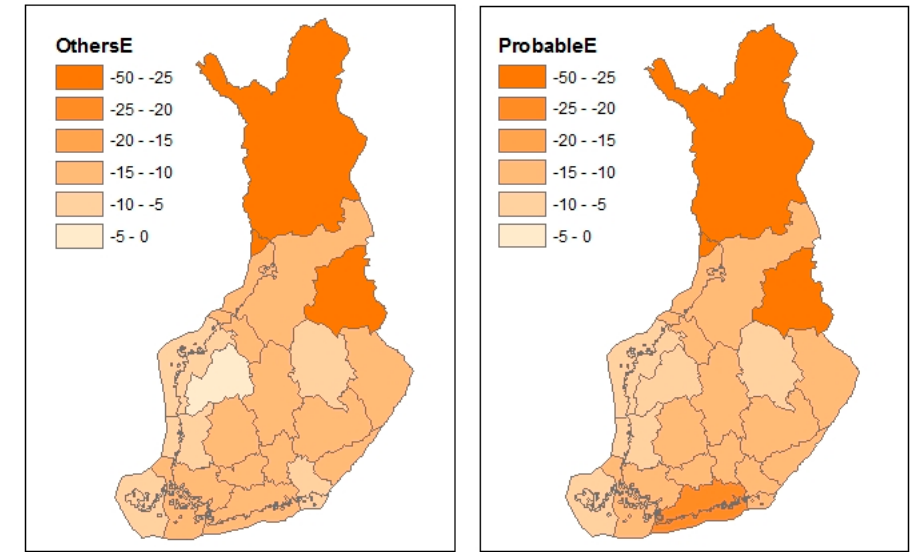
Figure 3. Estimated roundwood removals in 2016–2025 according to the scenarios OthersE and ProbableE, compared to the wood removal in the estimation without restrictions (WRE) scenario (%) by the provinces in Finland. Digital map data: National Land Survey of Finland 2020.